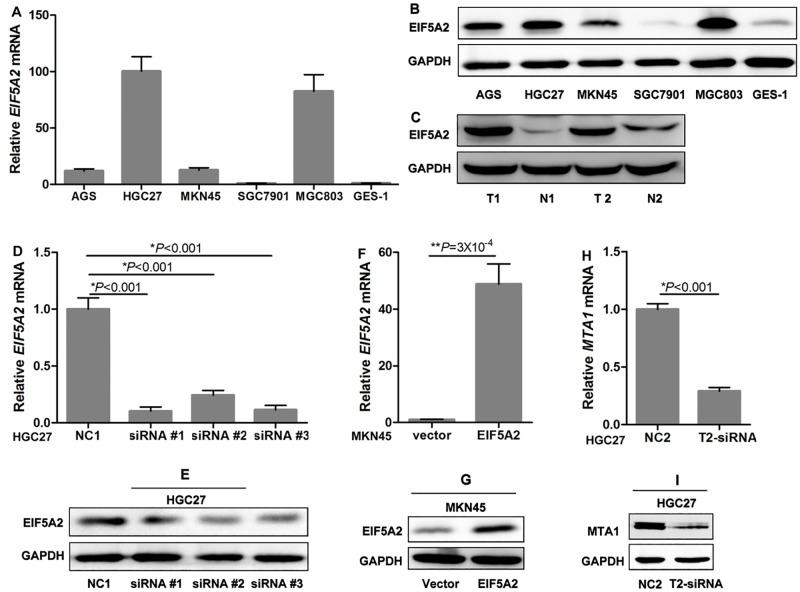
EIF5A2 Expression in GC cells and tissues and validation of the intervention.(A) EIF5A2 mRNA expression was examined by real-time quantitative RT-PCR with GAPDH serving as a loading control. (B) Protein expression in cell lines was confirmed by western blot analysis with GAPDH as a loading control. (C) EIF5A2 protein in human GC tissues was higher than that of the paired distant non-tumor tissues. (D) All three EIF5A2-siRNAs, especially #1, efficiently repressed EIF5A2 mRNA expression in HGC27 cells. (E) Western blotting reveals that EIF5A2 was knocked down by the treatment of EIF5A2- siRNAs in HGC27 cells. (F) EIF5A2 mRNA was significantly upregulated by transient transfection of EIF5A2 plasmids in MKN45 cells. (G) EIF5A2 protein was significantly upregulated by transient transfection of EIF5A2 plasmids in MKN45 cells. (H and I) T2-siRNA could efficiently suppress MTA1 expression in HGC27 cells.